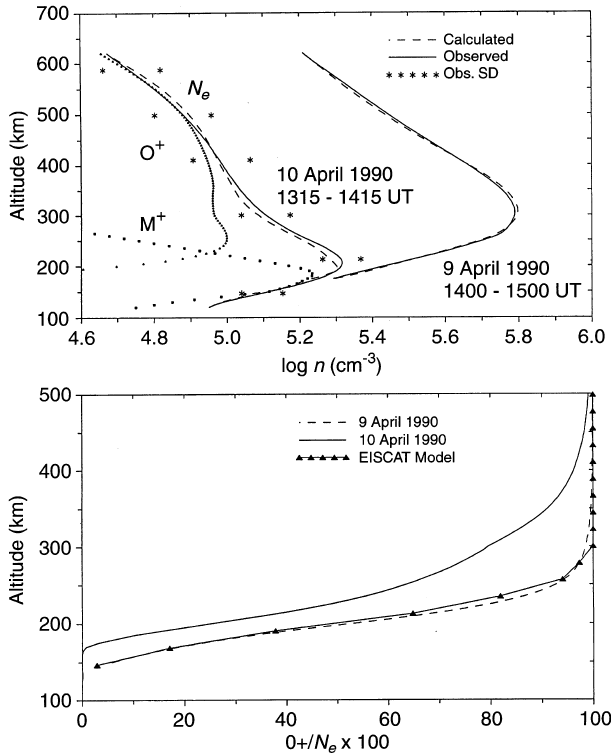
Fig. 4. Same as Fig. 3 but for 9–10 April 1990. Calculated atomic oxygen and molecular ion concentrations are shown as well (in the upper